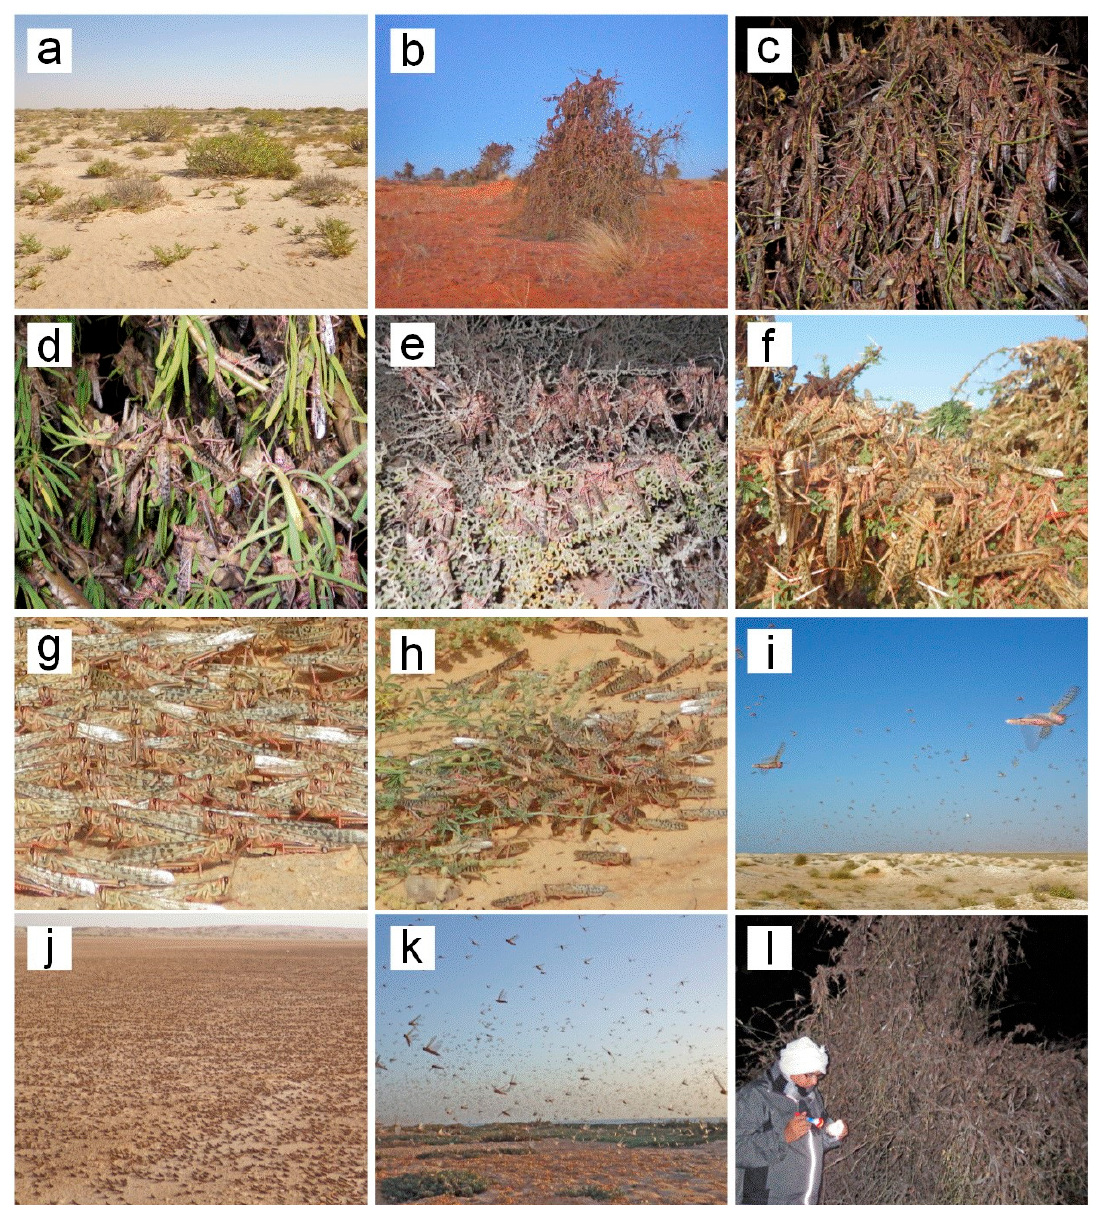
Figure 1. Habitats used by sexually immature swarms of Schistocerca gregaria for night-roosting sites and various diel behaviors in a population in Northwestern Mauritania during winter. ( a ) Habitats without trees and ( b ) with trees. ( c ) At night, locusts roosted on large trees ( Capparis decidua ), ( d ) medium-sized trees ( Euphorbia balsamifera ) and ( e ) small bushes ( Salsola imbricata ). ( f ) In the morning, locusts moved to the top of night-roosting trees or ( g ) to the open bare ground for basking. ( h ) Swarms feeding on low vegetation, ( i ) flying swarms, ( j ) settled swarms on the bare ground, ( k ) flying swarms along a coast, and ( l ) an observer staying near night-roosting swarms on a tree at night.